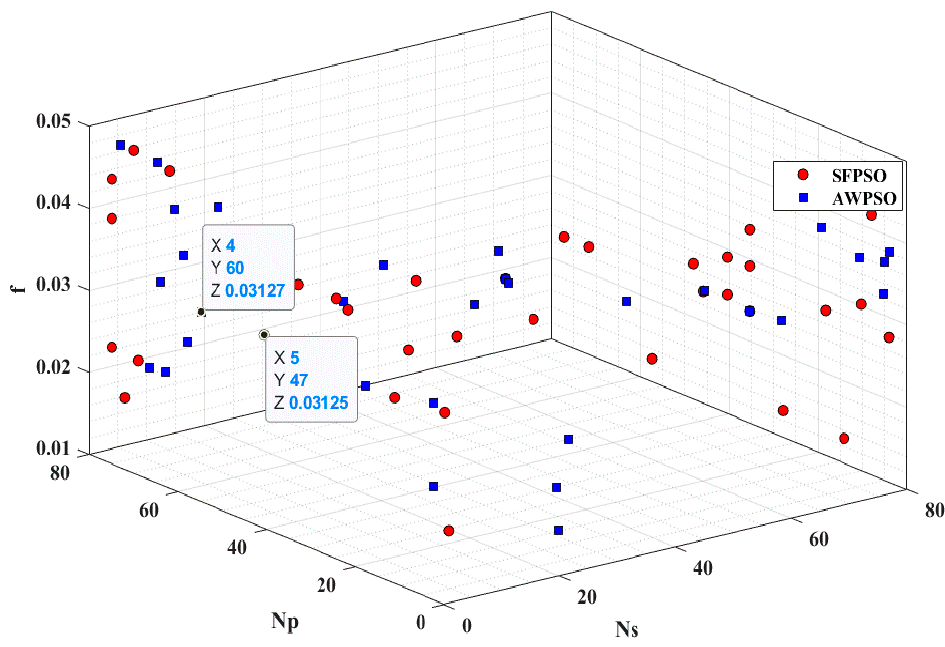
Figure 12. Evaluation of N s , N p ,and f value with di ff erent weights sets.